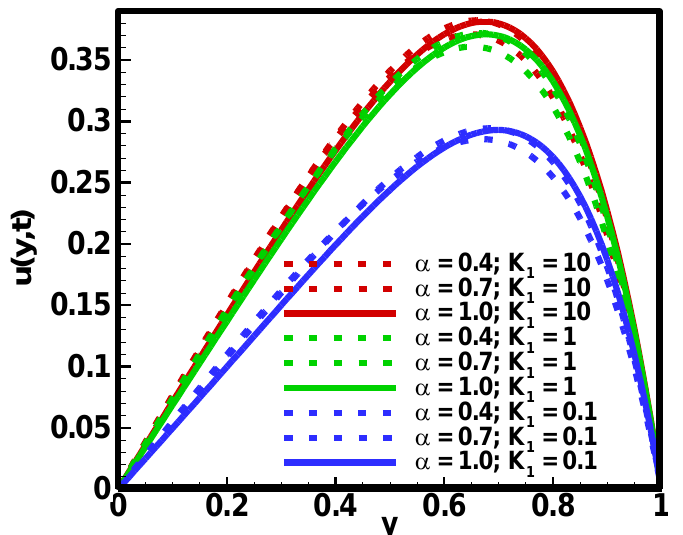
= 0.1, Gr = 5, λ β = 0.1, Pr = 21, 1 2